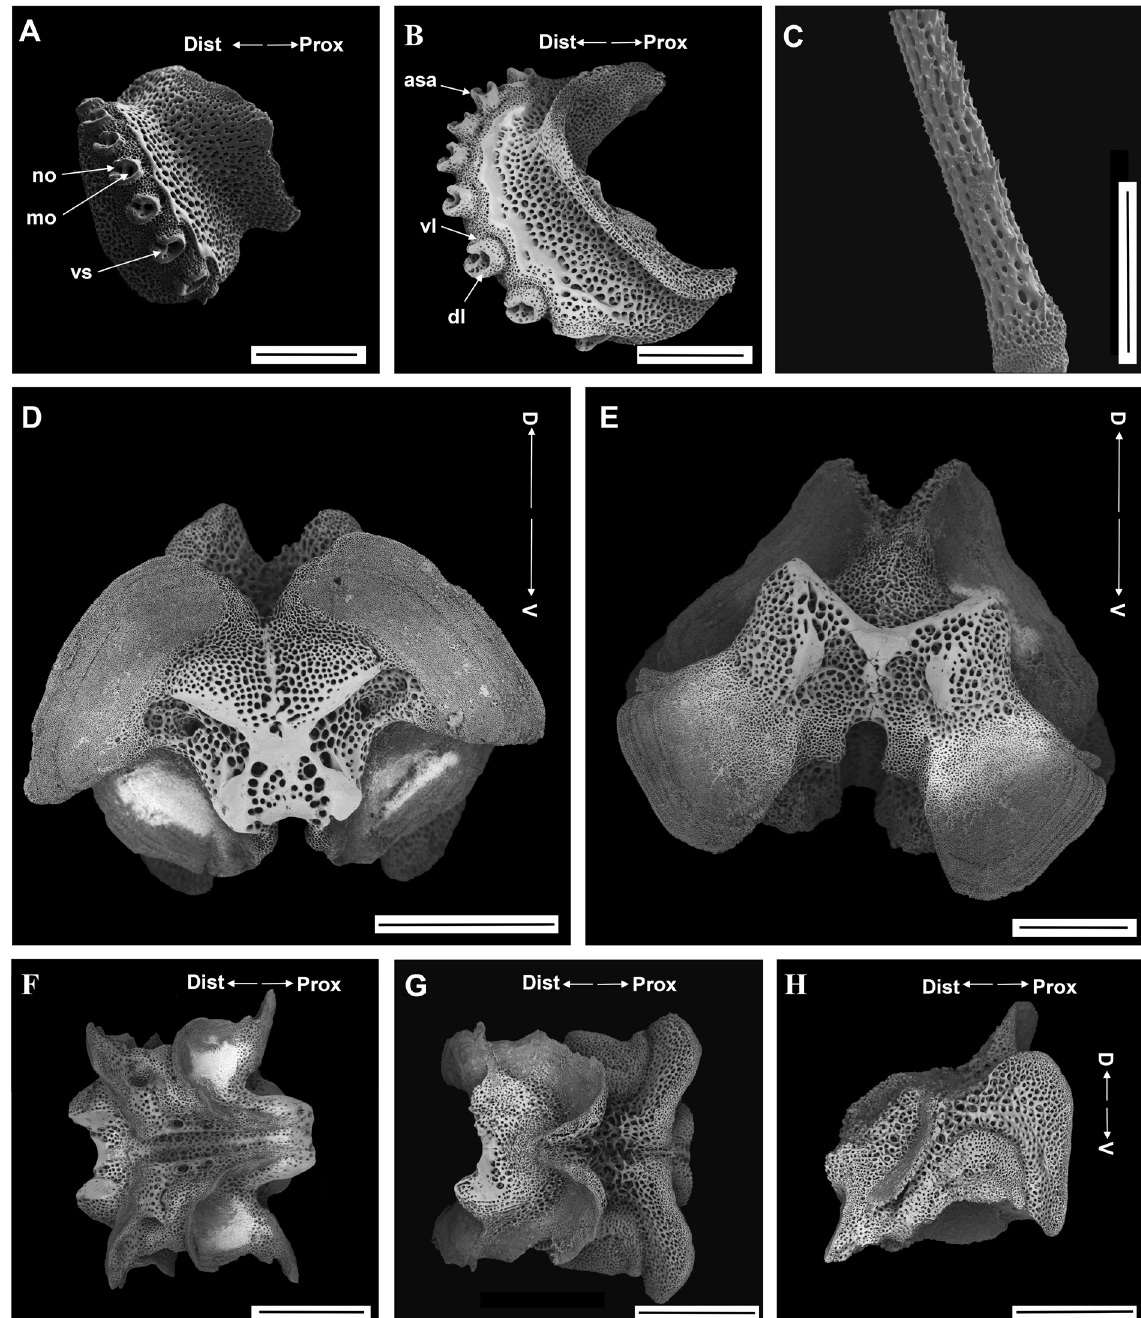
Fig. 32. Ophiacantha aster sp. nov., SEM, paratype (IDSSE EEB-SW0027). A–B . Lateral arm plate. C . Base of dorsal arm spine. D–H . Vertebrae. D . Proximal view. E . Distal view. F . Ventral view. G . Dorsal view. H . Lateral view (broken distal end). Abbreviations: asa = arm spine articulation; D = dorsal; Dist = distal; dl = dorsal lobe; mo = muscle opening; no = nerve opening; Prox = proximal; V = ventral; vl = ventral lobe; vs = volute-shaped. Scale bars: A–D, F–H = 500 µm; E = 300